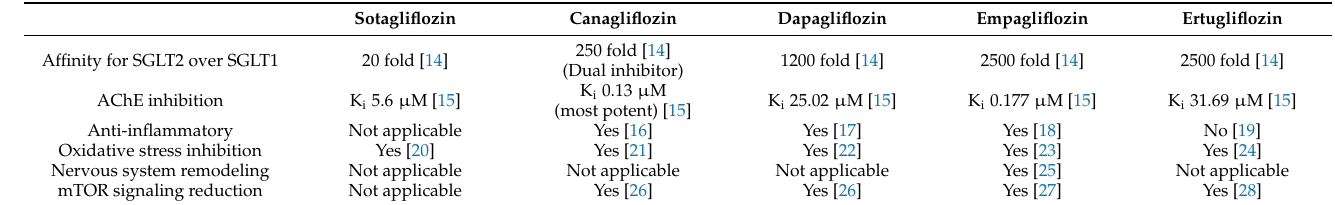
Table 1. Comparison between the SGLT2 inhibitors affinity and pleotropic effects.